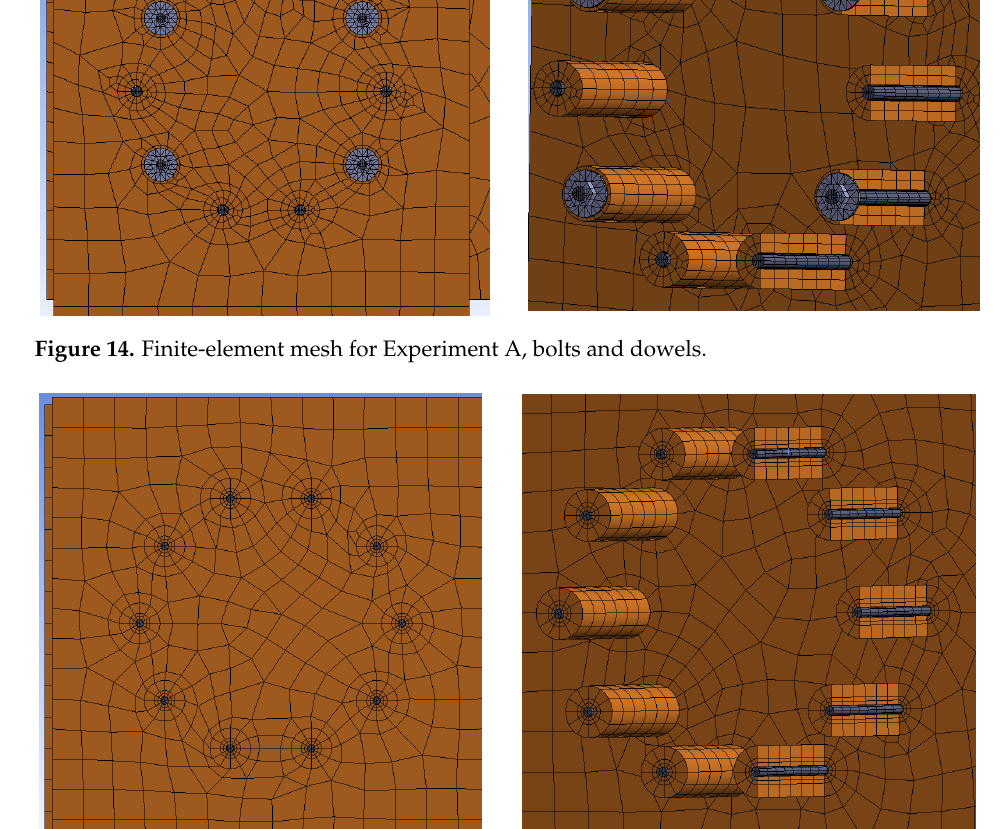
Figure 15. Finite ‐ element mesh for Experiment B, fully threaded screws. Figure 15. Finite-element mesh for Experiment B, fully threaded